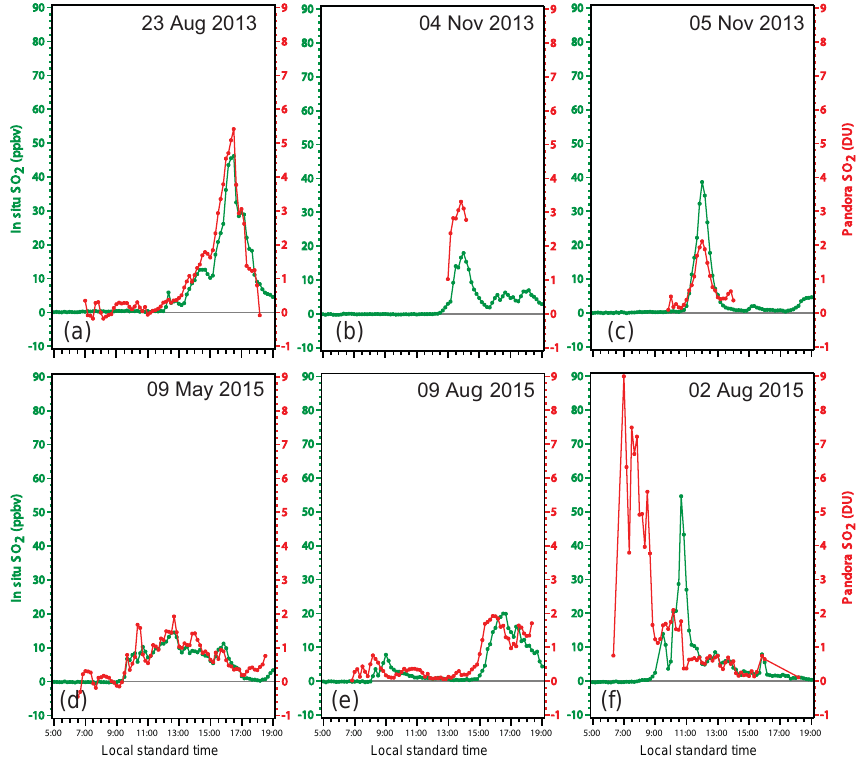
Figure 7. Vertical column density (DU) measured by the Pandora spectrometer at Fort McKay and in situ SO 2 concentration (ppbv) measured at the same location for 6 days, which illustrate fluctuations of VCDs and surface concentrations. Note that the vertical scales are the same for all six plots.